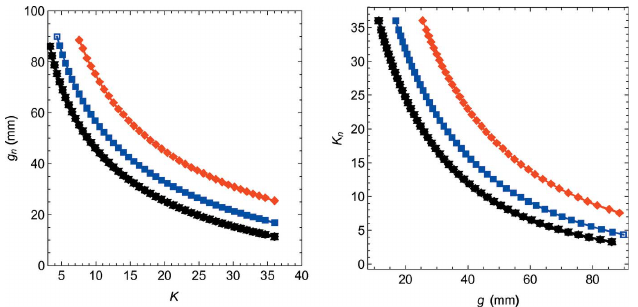
Figure 6 On the left in red: g 1 and g 18 (on the right: K 1 and K 18 ); in blue: g 2 and g 17 ( K 2 and K 17 ); in black: g 3 to g 16 ( K 3 to K 16 ). On the left side, the data are as-measured; on the right side, the data have been rearranged and fitted for the